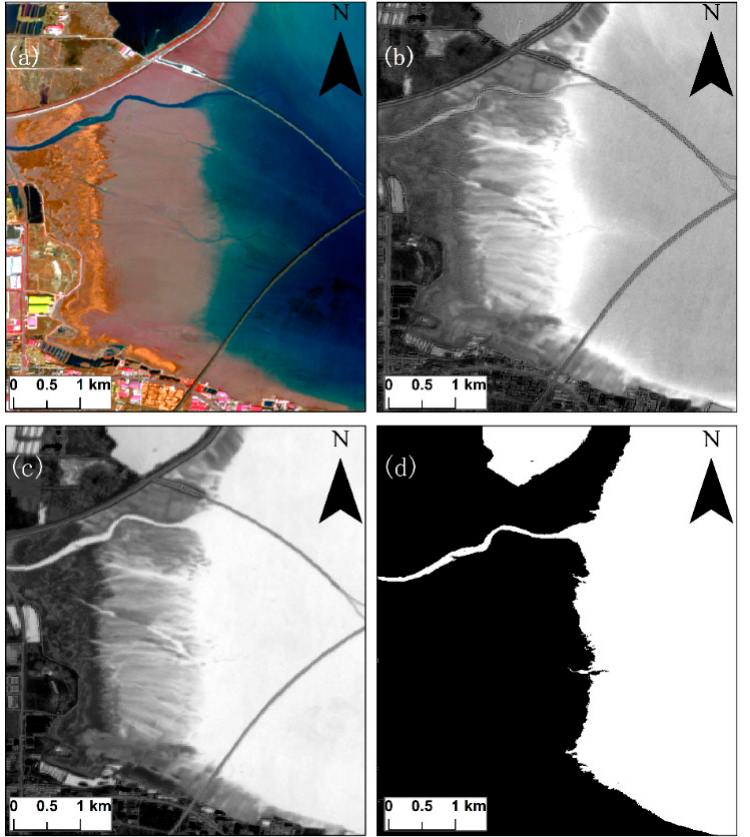
Figure 7. Comparison of three waterline extraction algorithms. ( a ) The reflectance difference of barren mudflat and seawater; ( b ) LSWI; ( c ) mNDWI; ( d ) EWBI > 0. First, the EWBI was proposed based on the difference in spectral reflectance between tidal flats and nontidal flats along Jiaozhou Bay, as shown in Equation (3). This index can highlight the boundary of the waters along Jiaozhou Bay and yield an accurate in- stantaneous waterline. Second, the EWBI image was segmented with 0 as the threshold to generate a binary image of land and water. Then, the Canny operator was used to detect whether each pixel was an edge pixel to extract the waterline. Finally, the extracted waterline was revised through visual interpretation. To extract tidal flat information, the outermost low tide waterline was selected as the lower boundary of the tidal flats, and the innermost high tide waterline was selected as the upper boundary of the tidal flats [14]. Due to changes in daily tide levels, weather, and other factors, the tidal movement in the same area may vary, causing different water lines to cross each other. To determine the accurate tidal flat range, the DSAS plug-in in ArcGIS software was used to generate a cross-section every 100 m along the coastline of the study area. The intersection of the cross-section and the waterline was considered the tidal point, which represents the instantaneous tide level at the time of satellite overpass. The distance between each tide point and the baseline was calculated for each section. The nearest and farthest points from the baseline were selected to form a high tide point set and low tide point set, respectively, and all high tide points and low tide points were connected to determine the annual high tide line and low tide line. Finally, the upper and lower boundaries of the tidal flats were determined in this study (Figure